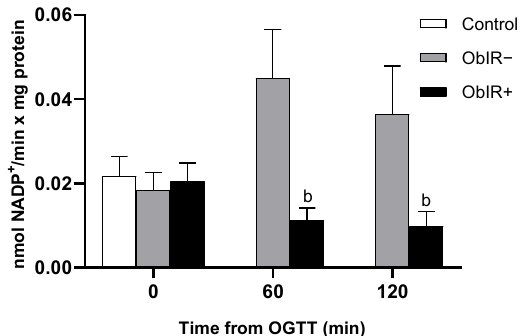
Figure 5. Glutathione reductase activity in RBCs of healthy and obese children. Glutathione reductase activity were measured in RBCs at baseline and along OGTT. White bars represent the control group, grey bars represent ObIR − group, and black bars represent ObIR+ group. Values are means ± SEM. p < 0.05 was considered for statistical significance. (b) shows significant differences relative to ObIR − .